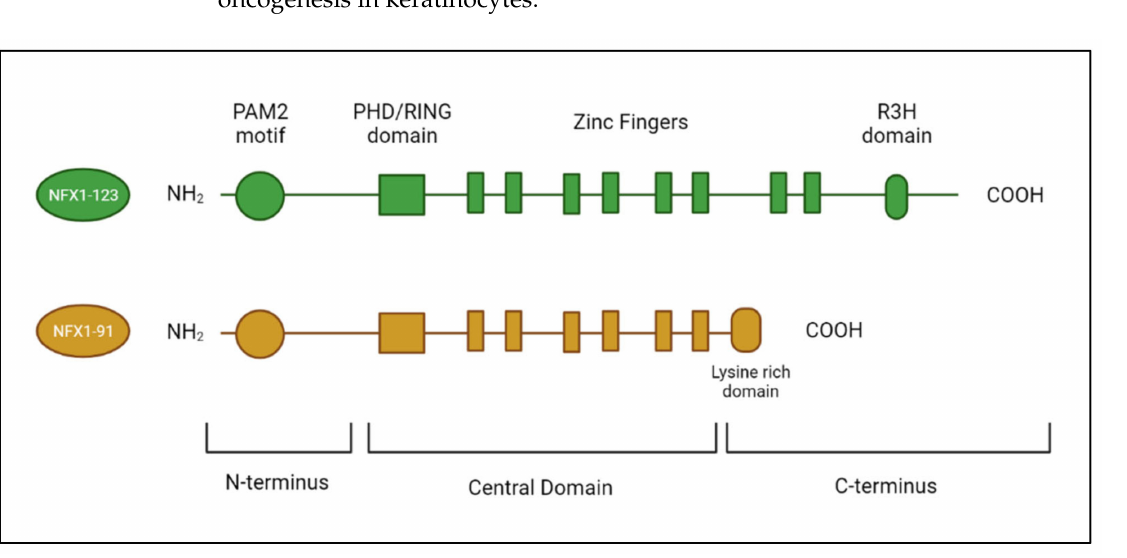
Figure 2. Splice variants of NFX1 . The two splice variants of NFX1 (NFX1-123 and NFX1-91) share a common N-terminus, which contains a PAM2 motif, and a central domain, which contains a PHD/RING and six zinc-like fingers. The C-terminus of NFX1-123 contains two additional zinc-like fingers and an R3H domain. The C-terminus of NFX1-91 is truncated and lysine-rich. Figure created with Biorender.com.